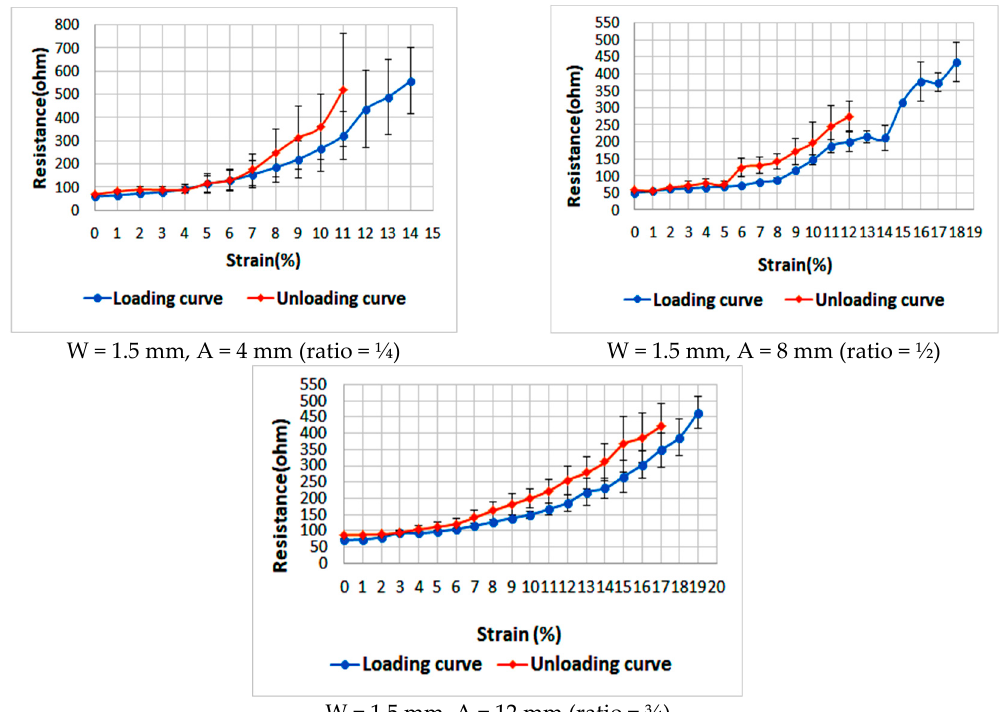
Figure A3. Average resistances of two sinusoidal samples at a width of 1.5 mm and various amplitudes as the applied strain increases (loading) and decreases (unloading). Error bars indicate the standard deviation in the values of the resistances.